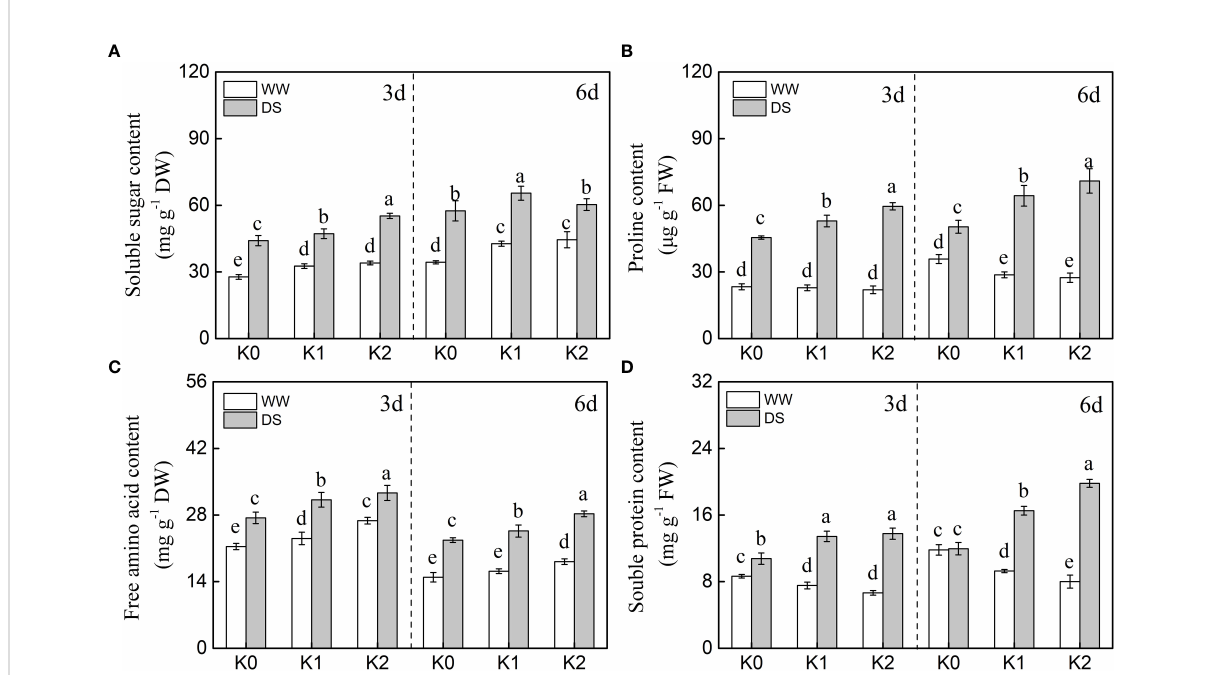
FIGURE 2 Effects of drought stress on osmotic adjustment substances [ (A) soluble sugar, (B) proline, (C) free amino acid, (D) soluble protein) in sesame leaves at the fl owering stage under different K levels. K0, K1, and K2 represent K application rates at 0, 60, and 120 kg ha − 1 K 2 O, respectively. 3 d and 6 d indicate the sample date from the initiation of drought stress. Lowercase letters show signi fi cant differences at the P <0.05